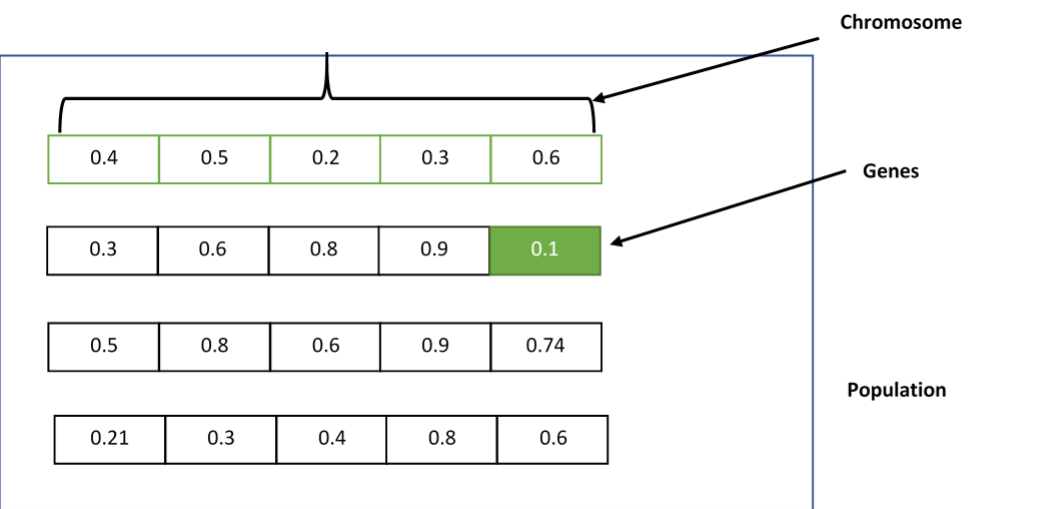
Figure 5. Selection process.